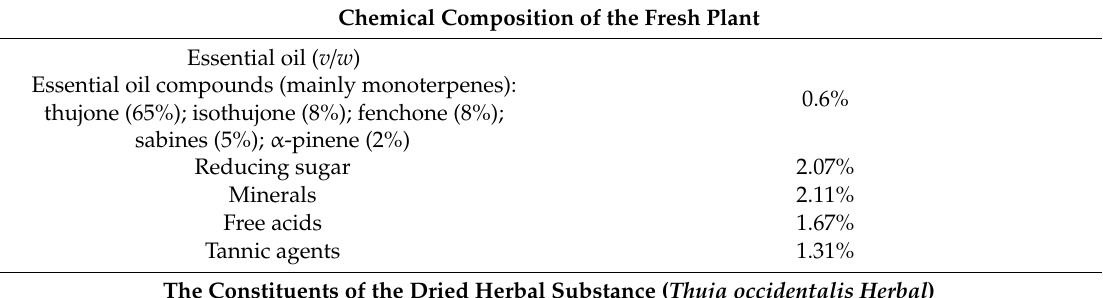
Table 2. The chemical composition of the fresh and dried T. occidentalis